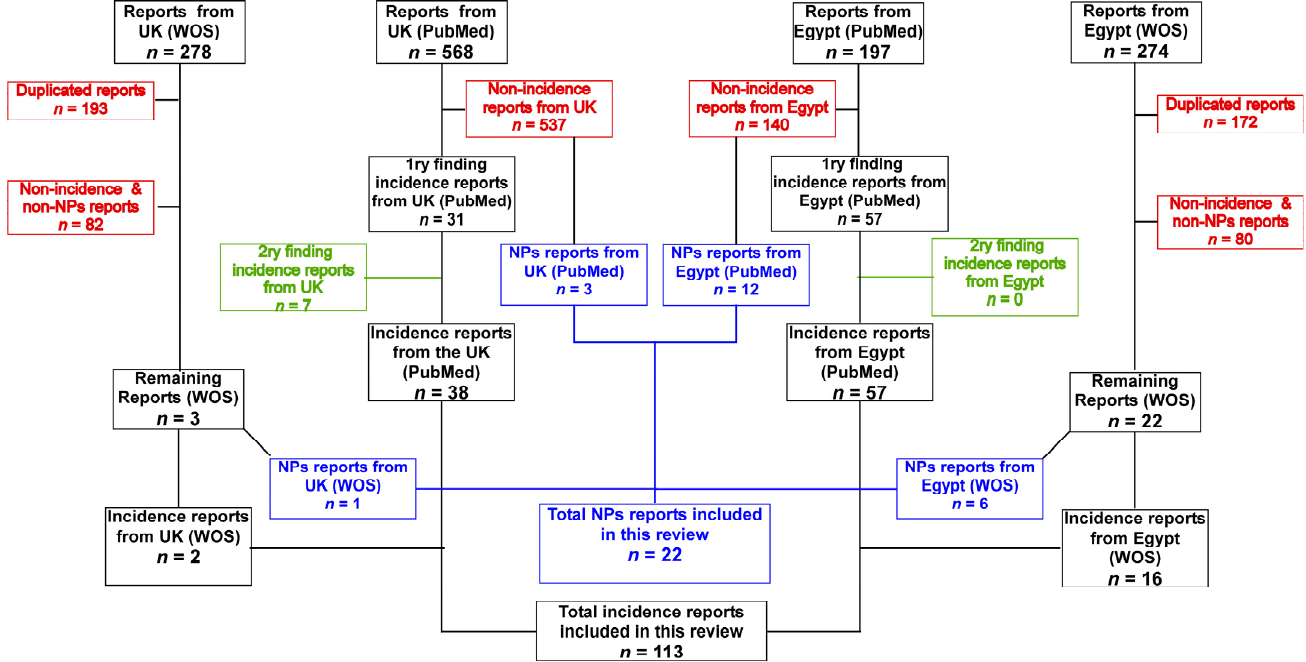
Figure 1. Flow diagram of the search strategy and selection of articles adopted in the current review. The 1ry findings were detected from the main database search, while the 2ry ones are those that were found upon examining the 1ry findings, and the information was cited from the 2ry after their retrieval and examination.